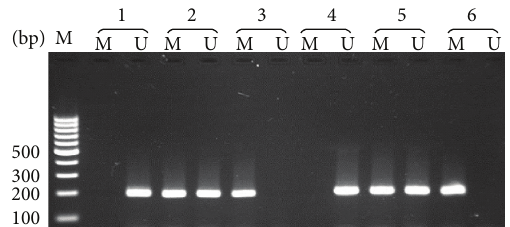
Figure 1: Methylation patterns of the RGC32 gene in breast carcinoma. “U” and “M” indicate unmethylated and methylated alleles, respectively. 1 and 4: UU; 2 and 5: MU; 3 and 6: MM.